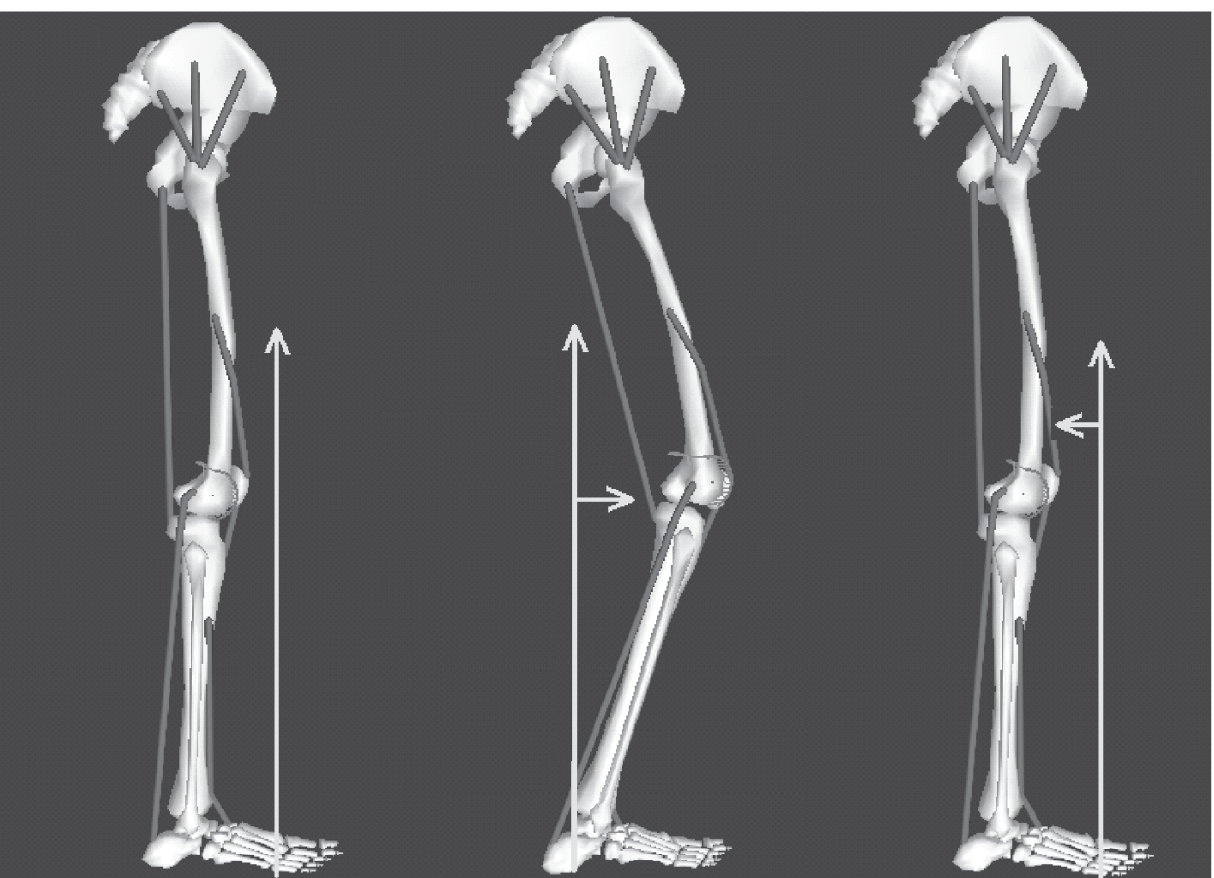
Figure 2 - The illustration of ground reaction force in normal gait, crouch gait and after the use of floor